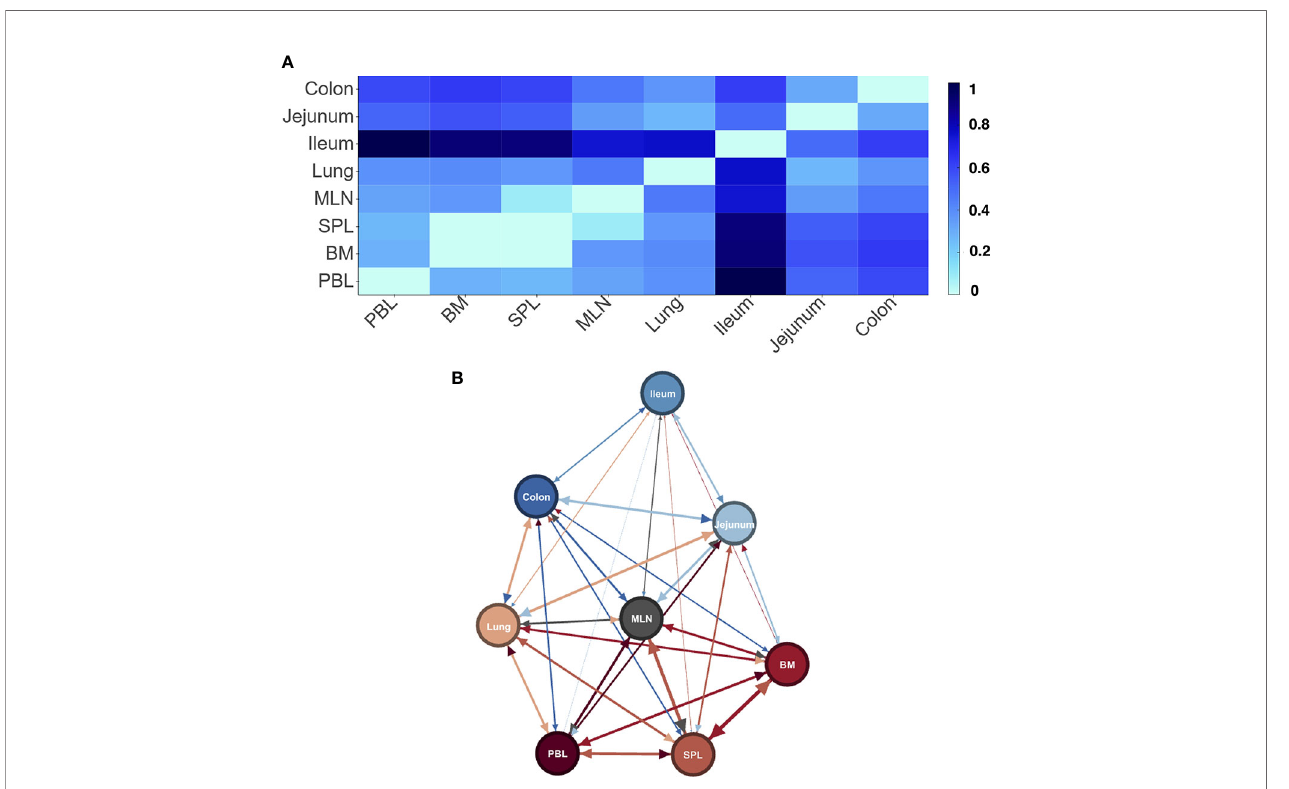
FIGURE 2 | Differences in LPA signatures of tissue based entities capture tissue differences in D207. Heatmap (A) and network representation (B) of the signature pair distances of tissue entities of donor D207. Darker colors (heat map) and longer/wider edges (network) signify greater difference between